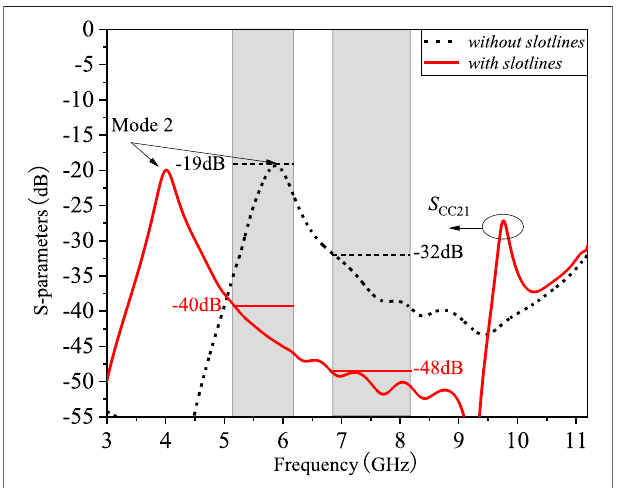
FIGURE 6 | Simulated frequency responses with and without slot lines on top and bottom metal layers.